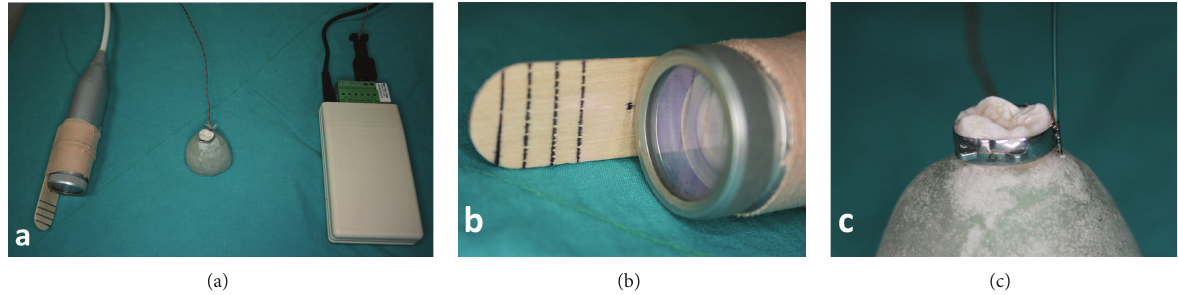
Figure 3: (a) The study design of the recent study. A thermocouple device on the right, the banded tooth with an acrylic platform in the middle, and the laser welding probe. (b) Fiber-delivered probe Nd :YAG laser on which 31mm stick was attached for standardization. (c) The welded stainless steel 0.016 󸀠󸀠 orthodontic wire to the molar band.